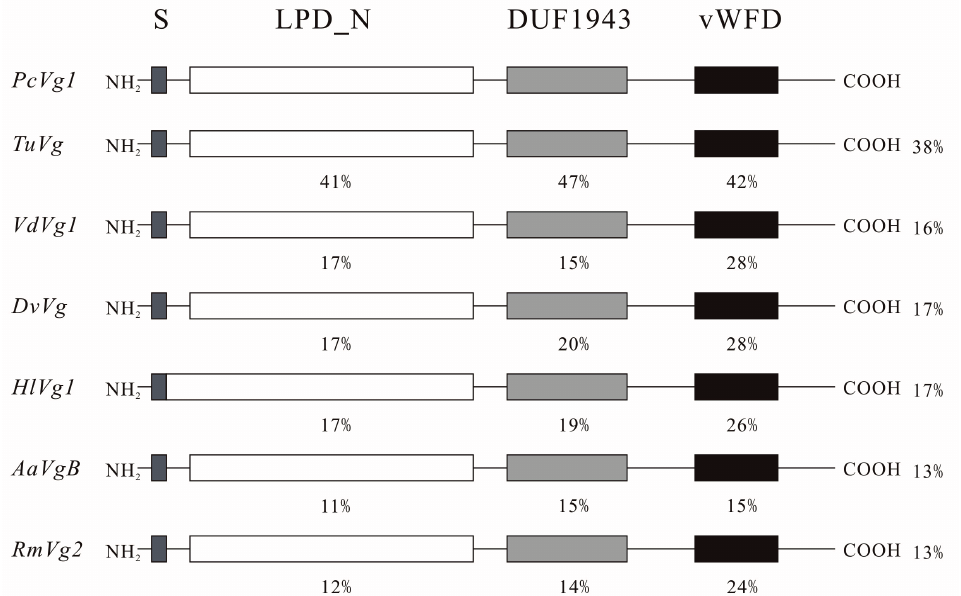
Figure 1. Schematic comparison of the primary protein structures of Panonychus citri vitellogenin 1 ( PcVg1 ) with those of other arthropod species. The percentage identity compared to PcVg1 for the specific domain is shown. The ratio (%) on the right side indicates the overall identity as compared with the PcVg1 . S, signal peptide; LPD_N, N -terminal lipoprotein domain; DUF1943, a domain of unknown function; vWD, von Willerand Factor type D domain. Sequences were taken from the Tetranychus urticae genome and GenBank database (accession ID or No. in parentheses): TuVg , T. urticae (tetur27g01310); VdVg1 , Varroa destructor (JQ974976); DvVg , Dermacentor variabilis (AY885250); HlVg1 , Haemaphysalis longicornis (AB359899); AaVgB , Aedes aegypti (AAQ92367); and RmVg2 , Rhyparobia maderae